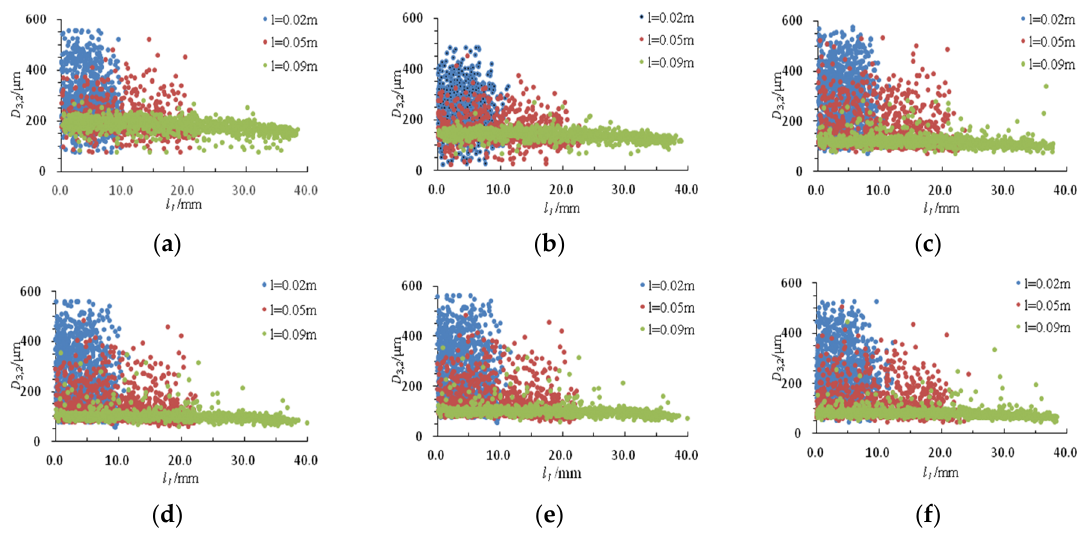
Figure 18. Particle diameter dispersion under different atomisation pressure: ( a ) 6 MPa; ( b ) 8 MPa; ( c ) 10 MPa; ( d ) 12 MPa; ( e ) 14 MPa; and ( f ) 16 MPa. The droplet particle diameter distribution of the paint formed at the completion of